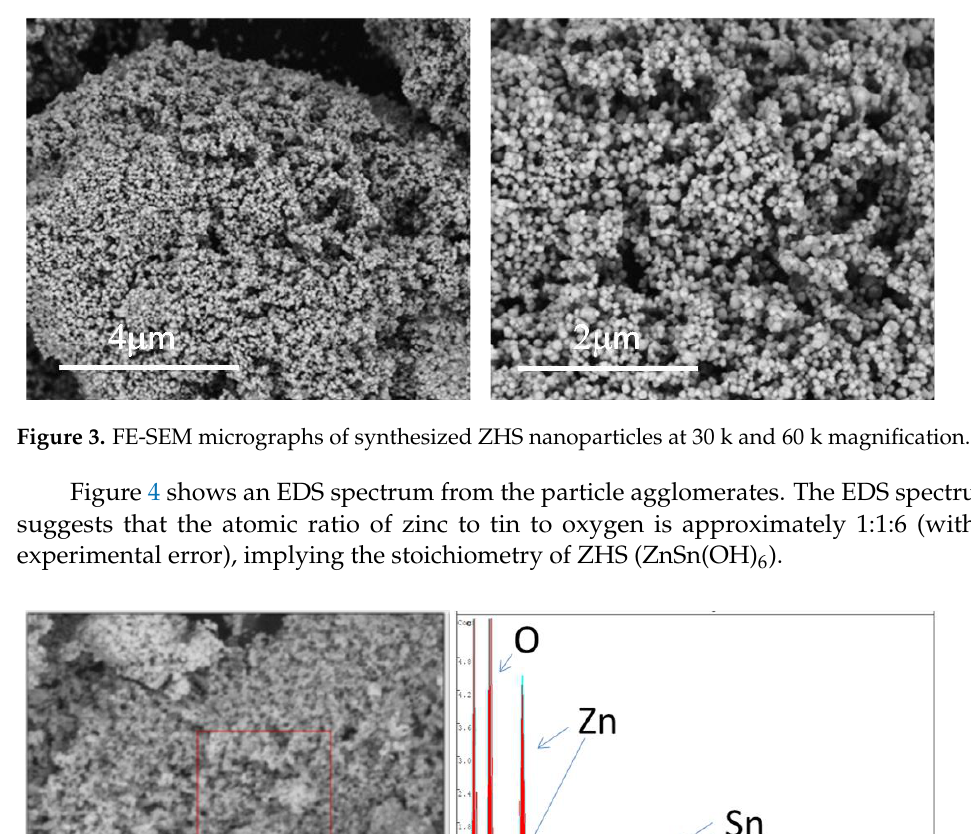
Figure 2 . X-ray diffractograms of ZHS synthesized, compared with standard pattern (ICDD/JCPDS, PDF no. 20-1455).